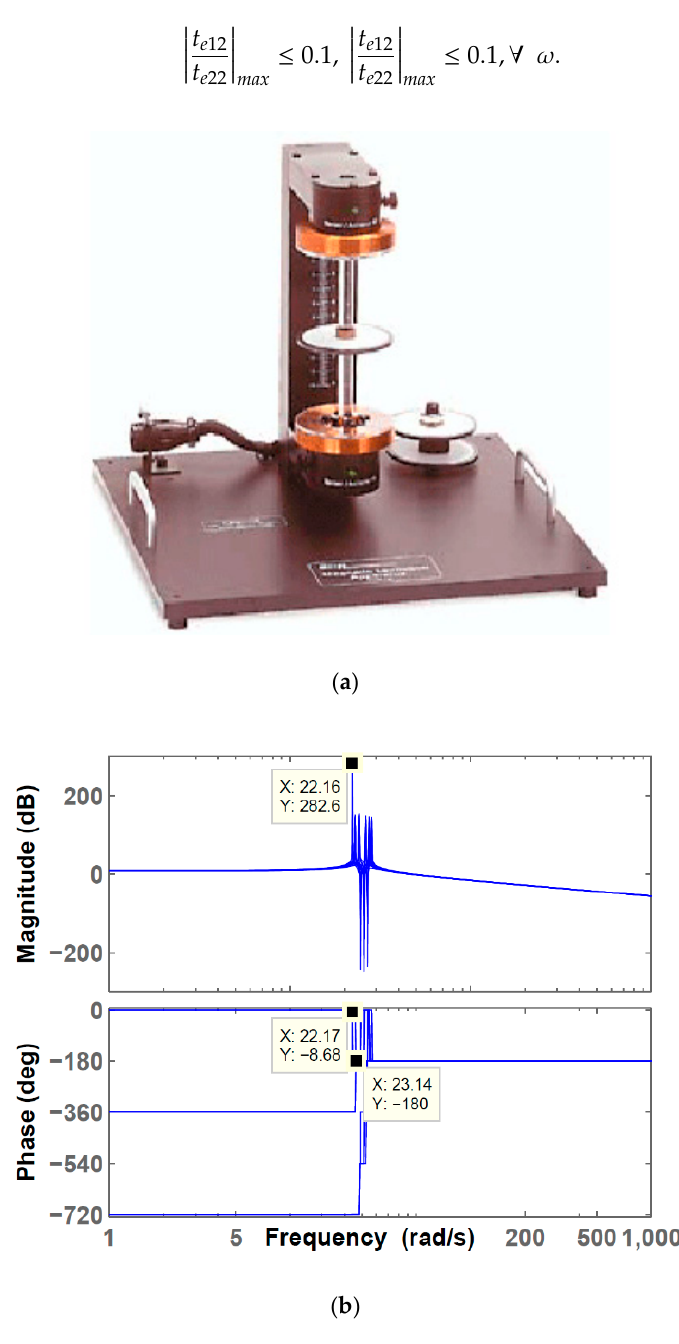
Figure 4. ( a ) Magnetic levitation system [20], and ( b ) Bode diagram of the lower magnet ( p 11 ) system (6561 randomly selected plants). Here, the peaks in magnitude ( ω = 22.16 rad / sec) and the phase shift (from − 8 to − 180 degrees) are shown.